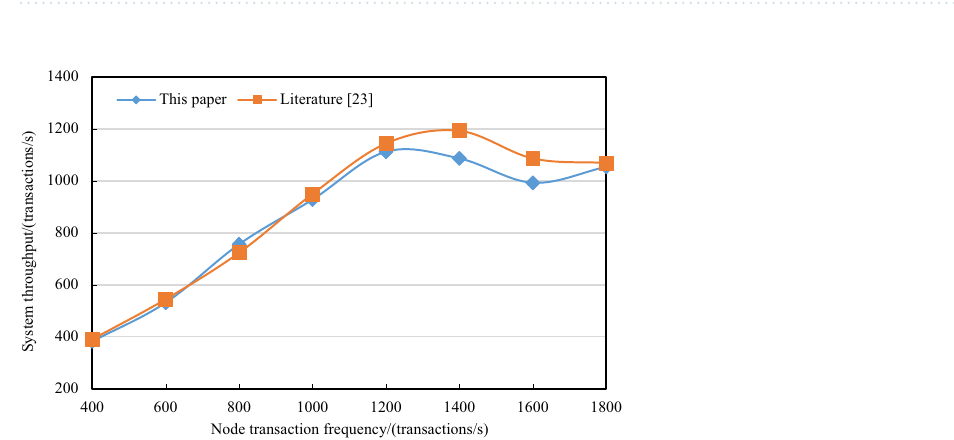
Table 4. Time-consuming comparisons of drawing storage, acquisition and contract execution.